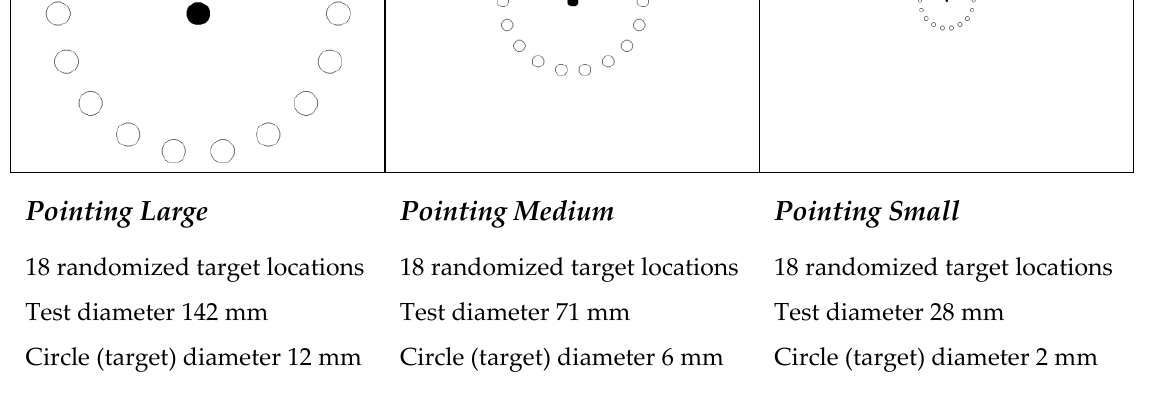
Figure 10. Pointing (and clicking) test tasks.